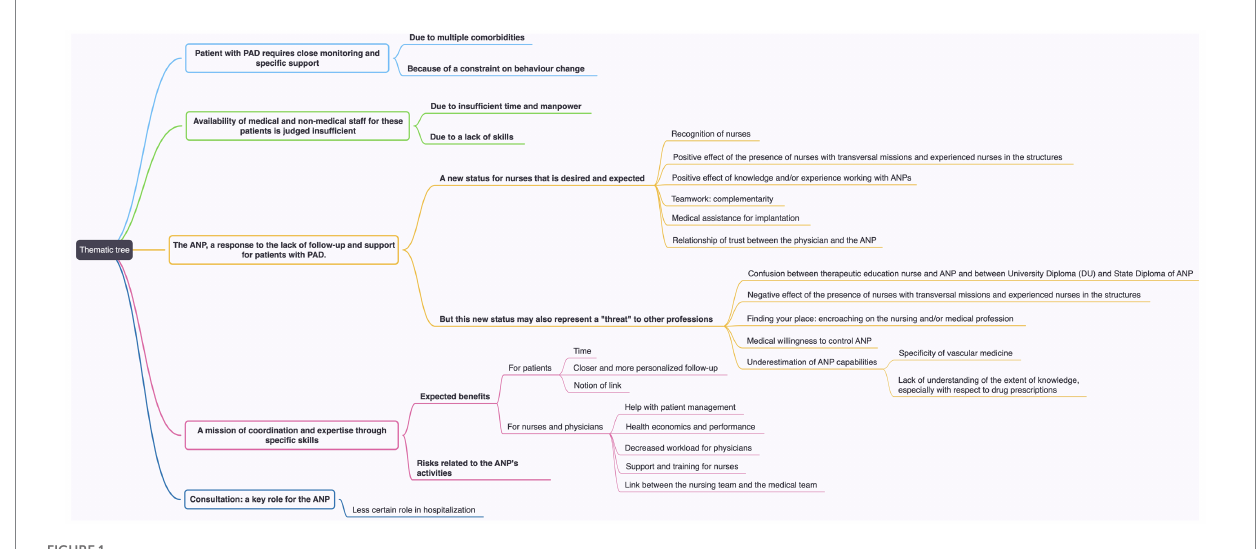
FIGURE 1 Thematic tree based on the data analysis. ANP, advanced nurse practitioner; PAD, peripheral artery